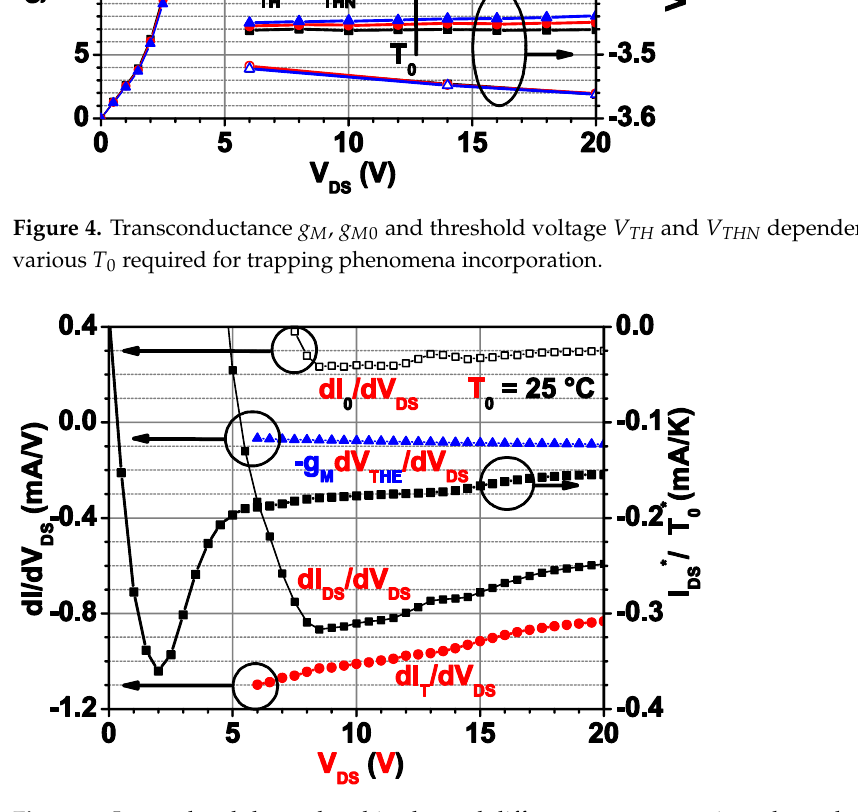
Figure 5. Interpolated thermal and isothermal difference current sections dependence on V DS at T 0 ≈ 25 ◦